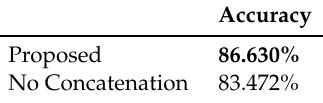
Table 4. The effect of the concatenation of the output from the embedding